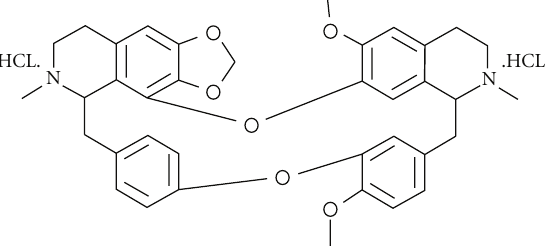
Figure 1: The chemical structure of CH used in the present study.